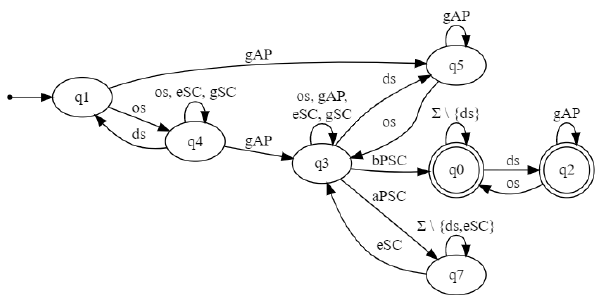
Figure 8. E-commerce system: Automaton for Ψ 1 ( C ) .